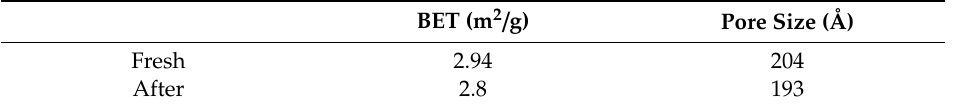
Figure 6. XRD patterns of the 3 wt% Ni / Ce-MgO-ZrO 2 / Al 2 O 3 catalyst: ( a ) before reforming and ( b ) after 200-h reforming. Table 3. Surface area and pore size of the 3 wt% Ni / Ce-ZrO 2 / Al 2 O 3 catalyst before and after